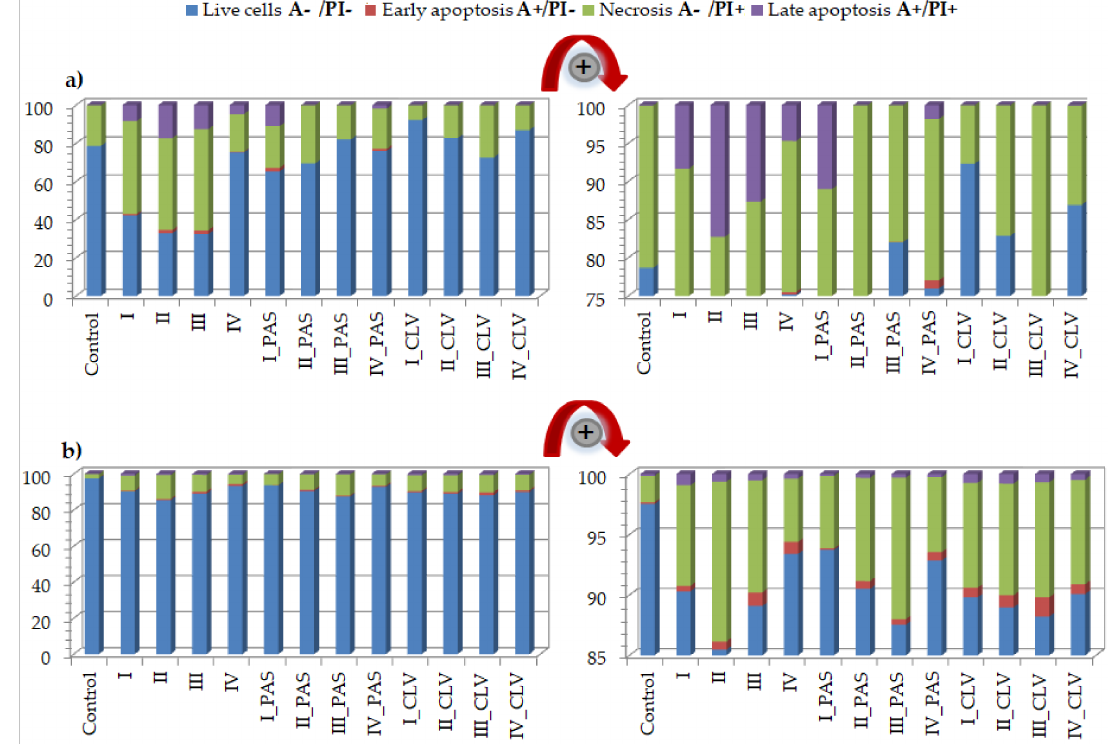
Figure 5. Annexin-V apoptosis assay results for ( a ) A549 and ( b ) BEAS-2B cell lines after the treatment of free carri- ers/conjugates and 72 h of